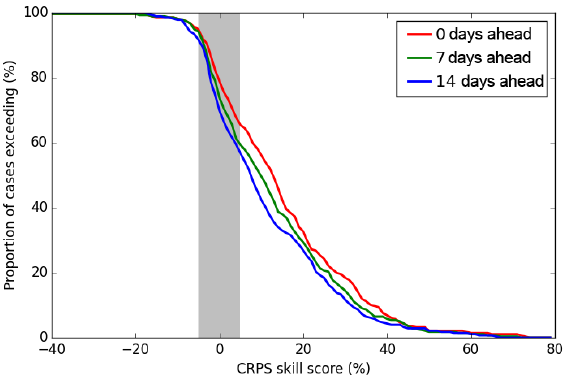
Figure 7. Proportion of cases exceeding CRPS skill score thresh- olds for lead times of 0, 7, and 14 days. For each lead time, the CRPS skill scores for each forecast location and season have been pooled. The grey shaded region indicates neutral skill ( ±